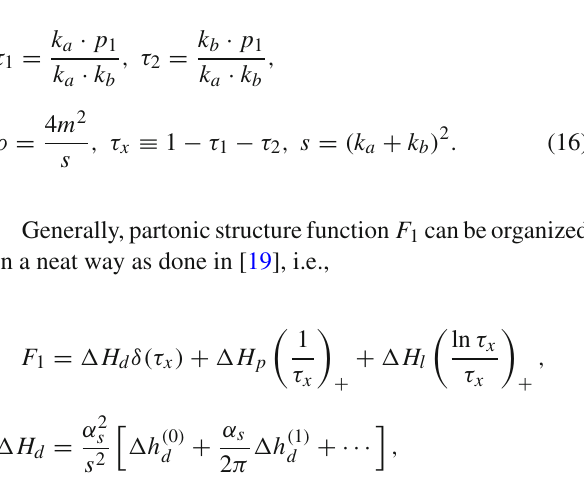
Fig. 2 Virtual corrections to the amplitude, where the bubbles in a , b represent vertex insertion and the bubble in e represents the insertion of gluon self-energy in Feynman gauge. Self-energy insertion to external